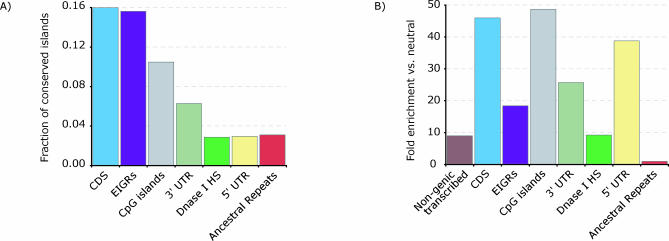
Islands of Conservation in Functionally Annotated Regions(A) Localization of short (5–12 bp) conserved islands in functionally annotated regions. Shown is the fraction of all islands that fall within a particular region. Nongenic transcribed regions were omitted to preserve scale, but contain 93% of short conserved islands.(B) Fold excess of short (5–12 bp) conserved islands in functionally annotated regions compared to ancestral repeat regions. Shown is the ratio of the density in each region (number of clusters divided by total number of positions in the region) to the density in ancestral repeat positions.